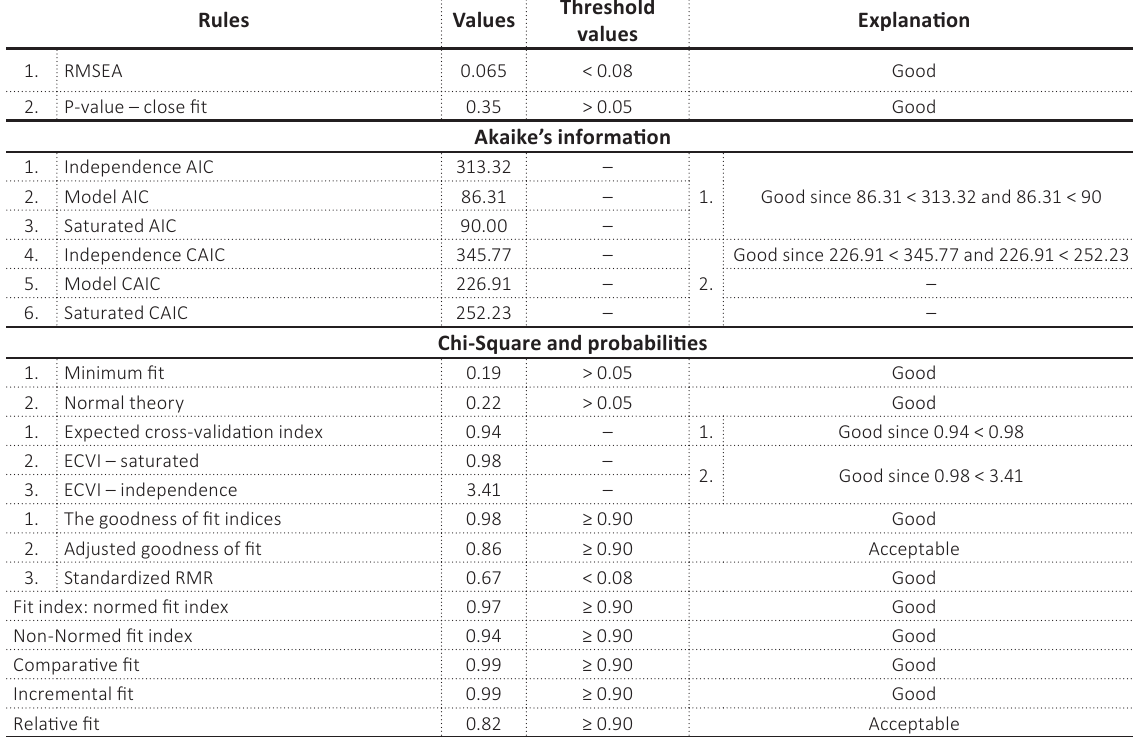
Table 5. A direct effect of variables in equations (4), (5), and (6)